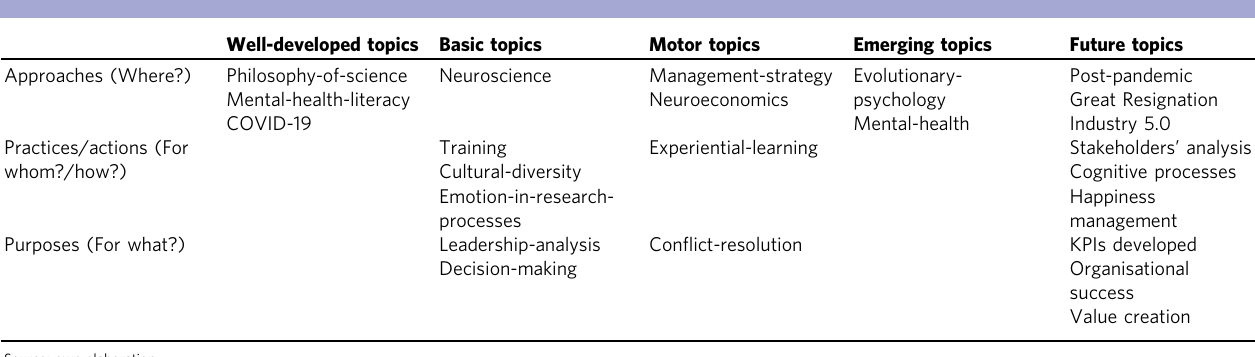
Table 2 A neuroleadership research